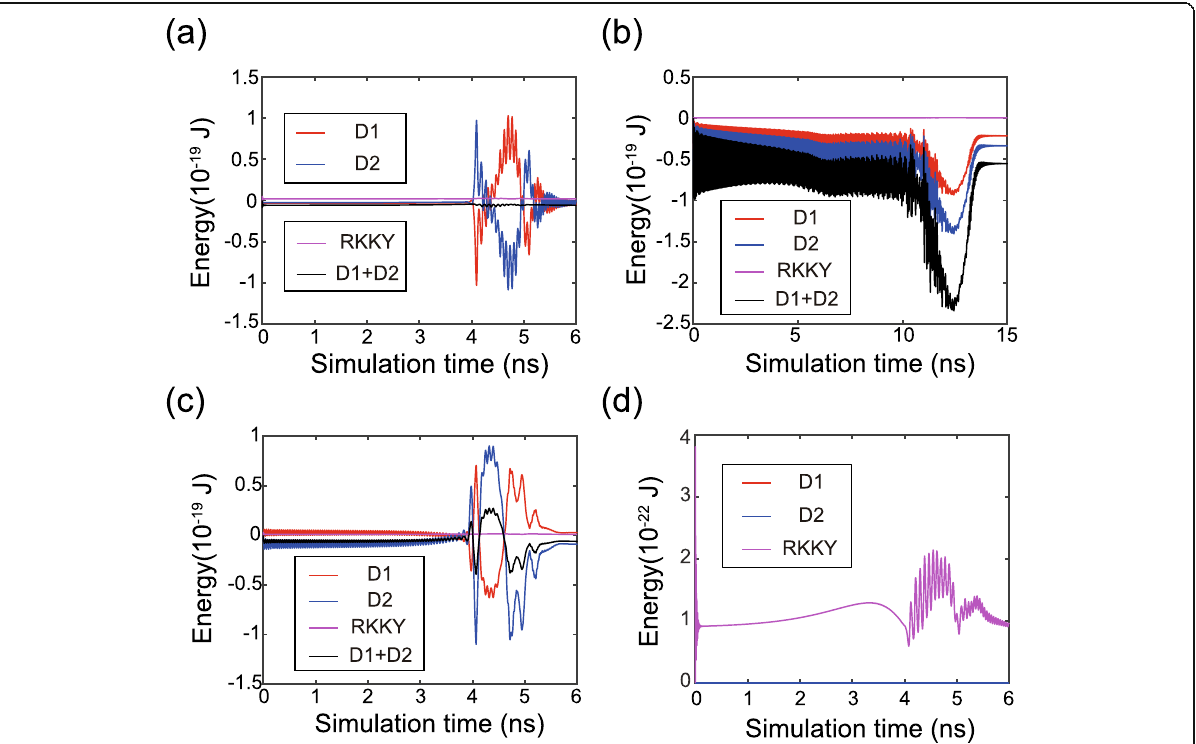
Fig. 5 Time evolution of the DMI and RKKY energies. a D 1 = 1.5 mJ/m 2 , D 2 = − 1 mJ/m 2 , i.e. DMI effect is canceled out. b D 1 = D 2 = 1 mJ/m 2 ,